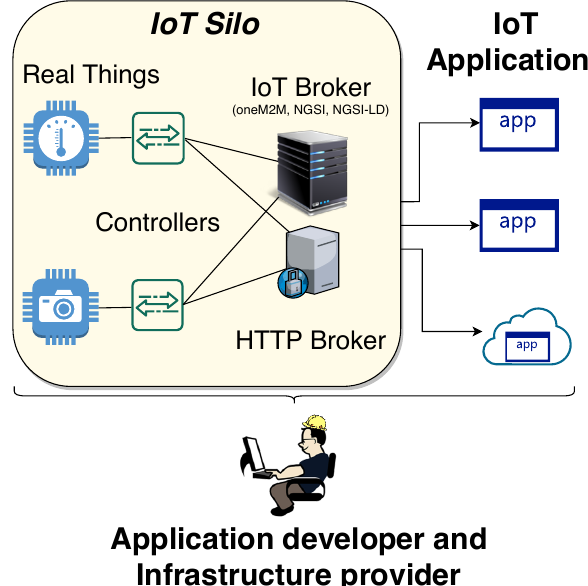
Figure 1. IoT applications based on IoT Silos.